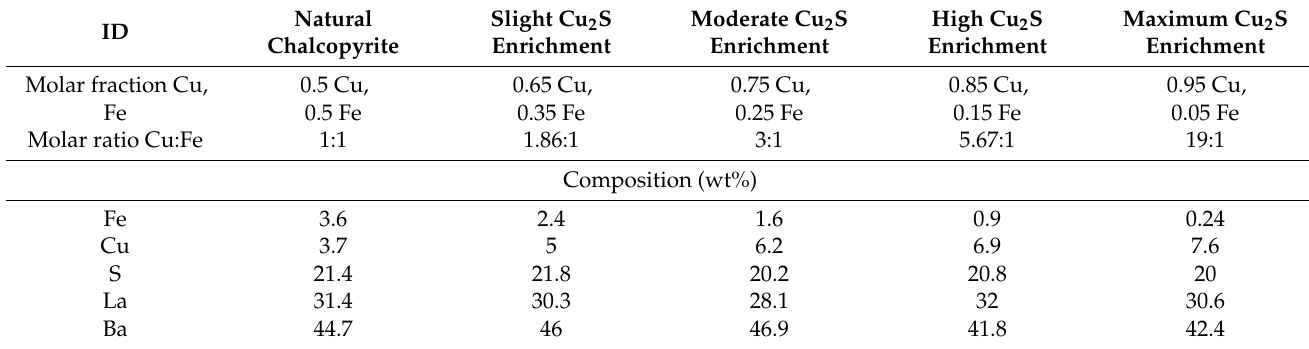
Table 4. The ID, molar fraction of copper and iron (in sulfide form) and molar ratio of copper to iron, as well as the composition (wt%) as measured by ICP-MS and LECO for each initial electrolyte for the 300 mA